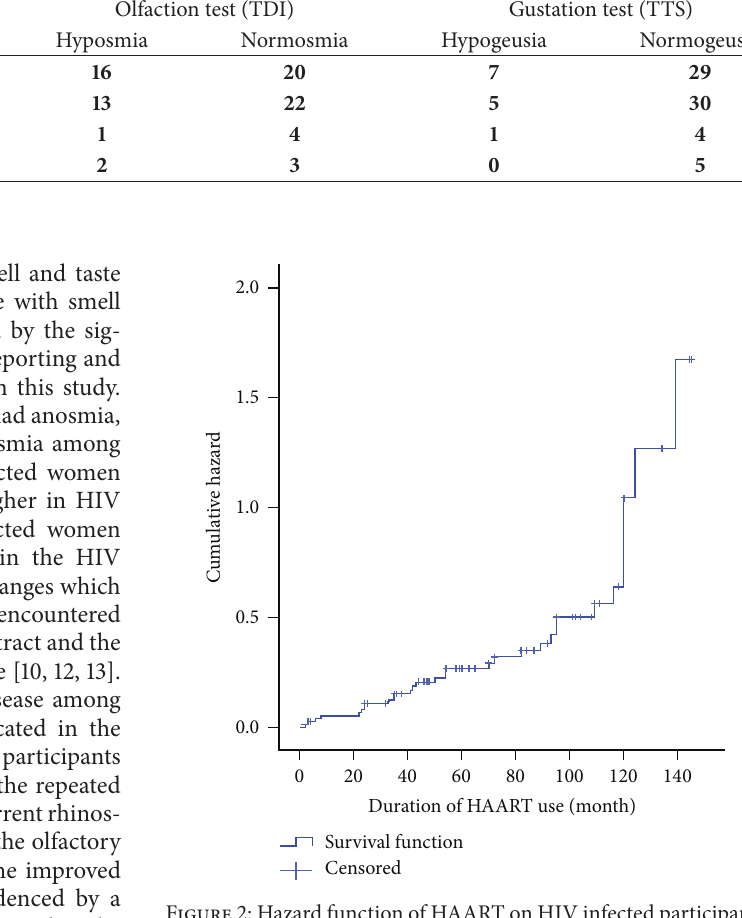
Table 6: Relationship of highly active antiretroviral therapy with hyposmia and hypogeusia. Highly active antiretroviral therapy (HAART)